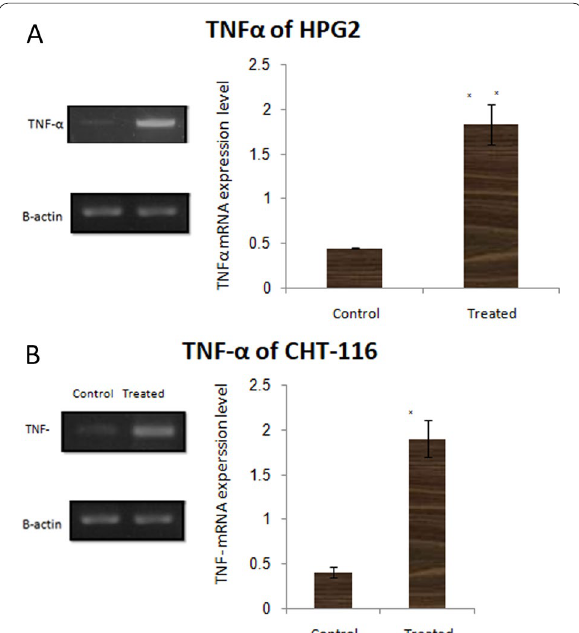
Fig. 8 PCR detected the expression of TNF‑α in HepG2 and HCT‑116 cells after treatment with NSP means *represents significantly dissimilar results (P <